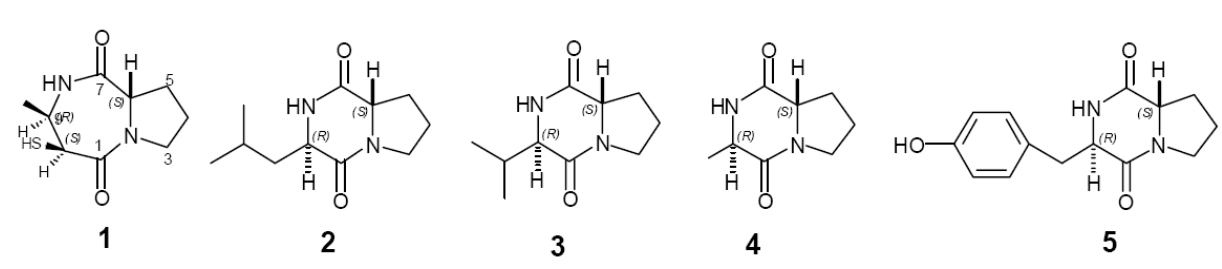
Figure 1. Structures of compounds 1 – 5